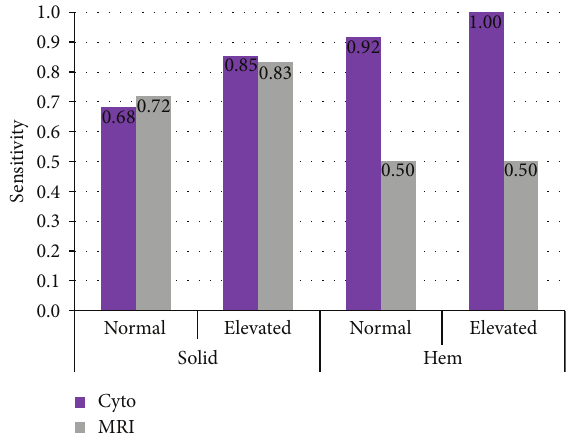
Figure 1: Diagnostic sensitivities of CSF cytology (“cyto”) and MRI, illustrated separately for solid (left) and elevated cell hematological (“hem”) (right) malignancies. and for normal and elevated cell